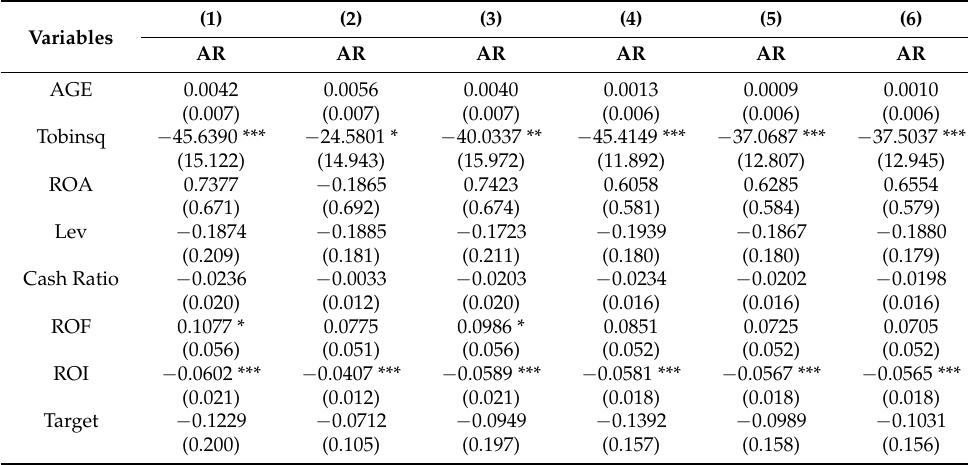
Table 9. Robustness checks on full